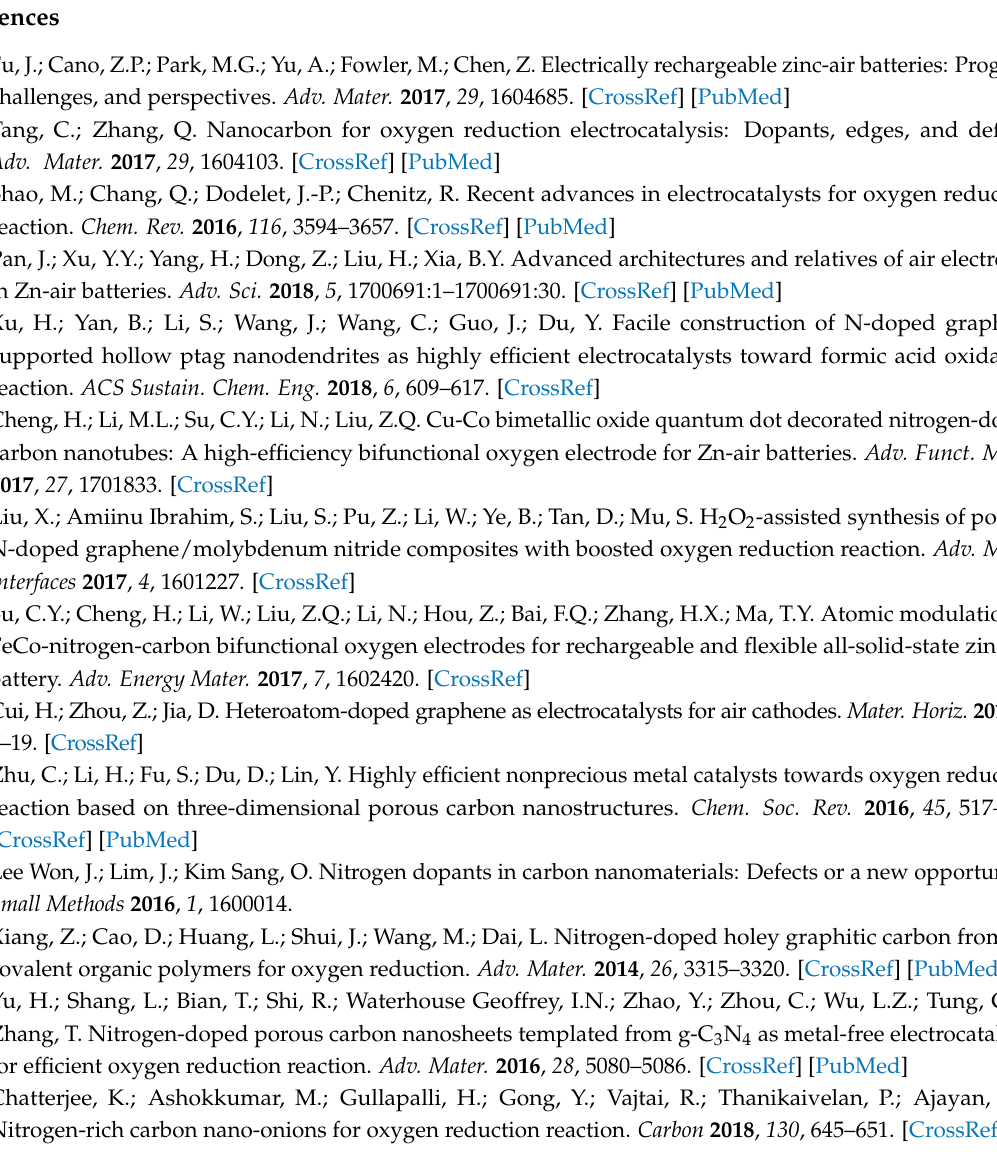
Figure S1: EDS spectra of ( a ) the BC/MB and ( b ) BC/PMB, Figure S2: SEM image of the PMB, Figure S3: The dark field TEM image of the C-BC/MB and the corresponding element mapping images of S, N, O and C, Figure S4: The diameter ( b ) and length ( c ) distribution of the nanofibers obtained from TEM image ( a ) of the sample N/S-CNF, Figure S5: Linear sweep voltammetry curves of the samples of N/S-CNF prepared at different condition. Fixed the other experiment parameters, ( a ) the concentration of MB in the adsorption process of MB on BC was varied from 0.01 to 0.1 mol/L; ( b ) the heat treatment temperature in the adsorption process of MB on BC was varied from 60 to 150 ◦ C; ( c ) the polymerization time of MB was varied from 0.5 to 6 h. All these linear sweep voltammetry curves were obtained from O 2 -saturated 0.1 M KOH solution at scan rate of 10 mv/s and a rotation rate of 1600